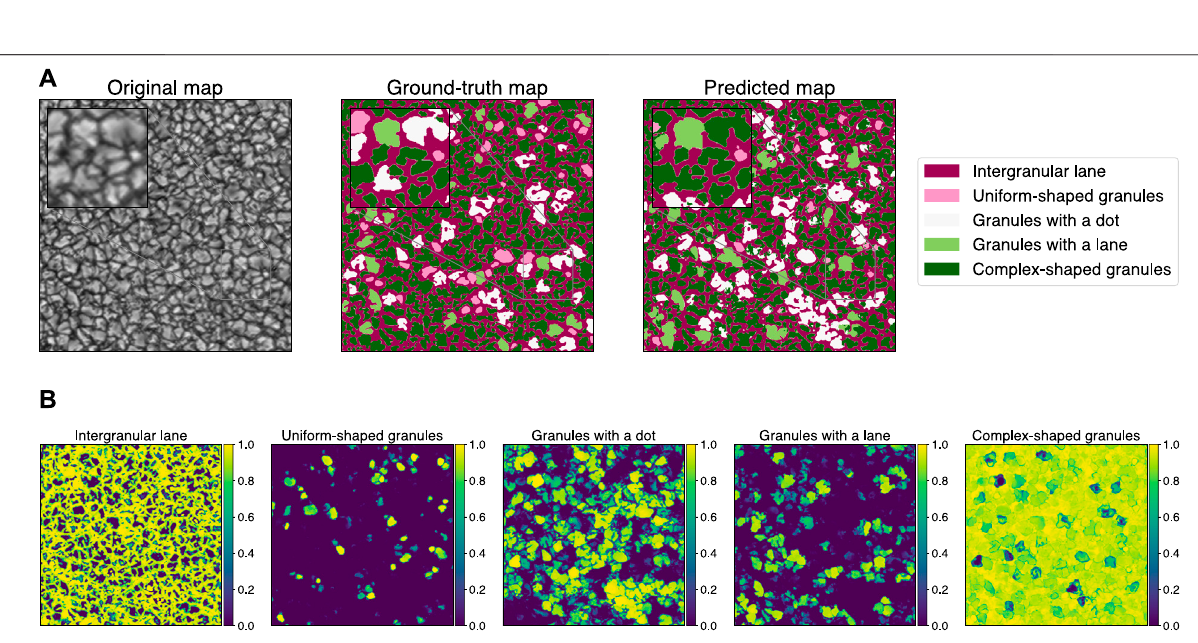
FIGURE 4 | (A) Comparative maps using the validation full size map – Test 1: U-net model using α -balanced Focal loss with γ = 10 as training loss function. A zoomed region is highlighted showing in detail the diverse constrains of the segmentation. (B) Probability maps per class using the validation full size map – Test 1: U-net model using α -balanced Focal loss with γ = 10 as training loss